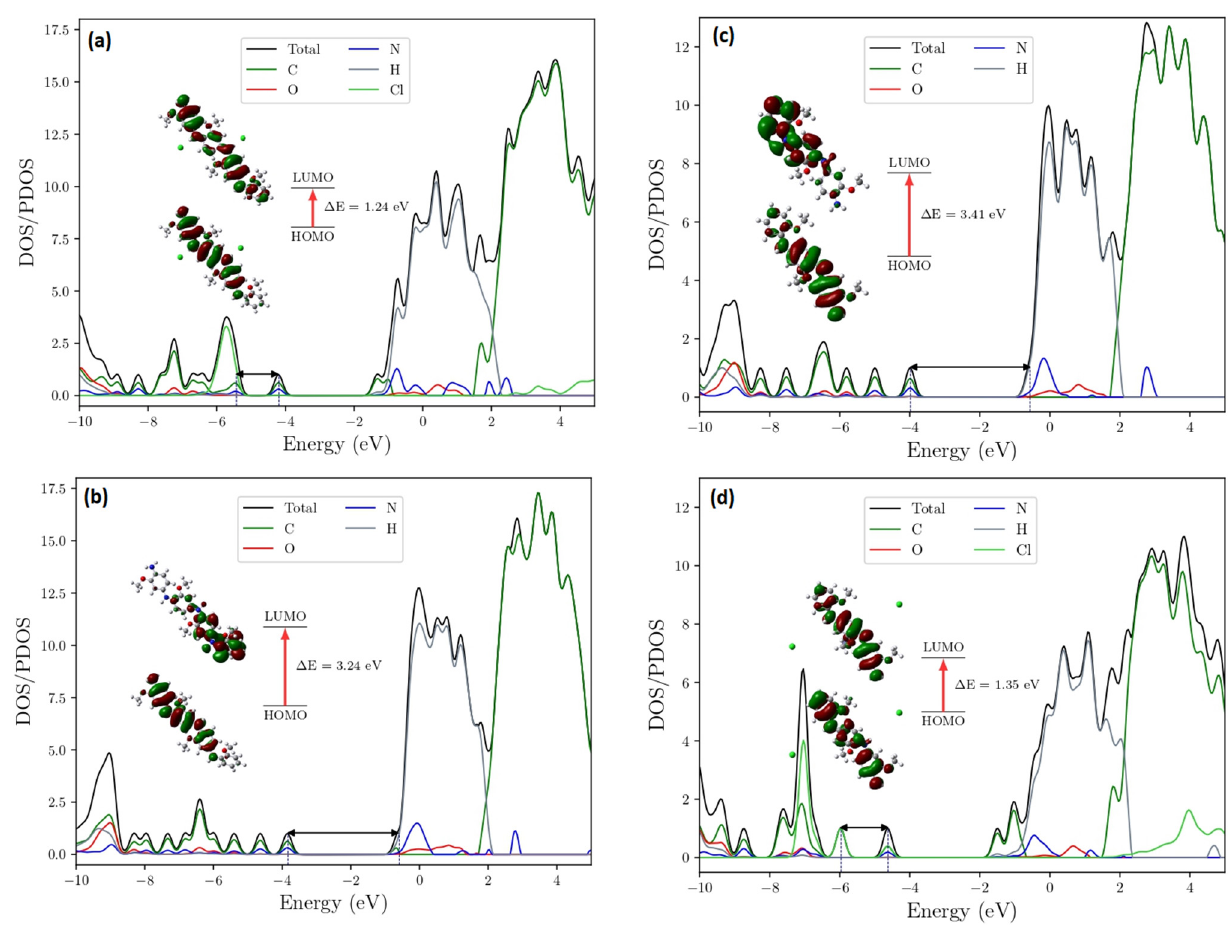
Figure 10. Gap energy and density of states (DOS/PDOS) of the ( a ) doped-POMA tetramer, ( b ) undoped-POMA tetramer, ( c ) undoped-POMA trimer, and ( d ) doped-POMA trimer.